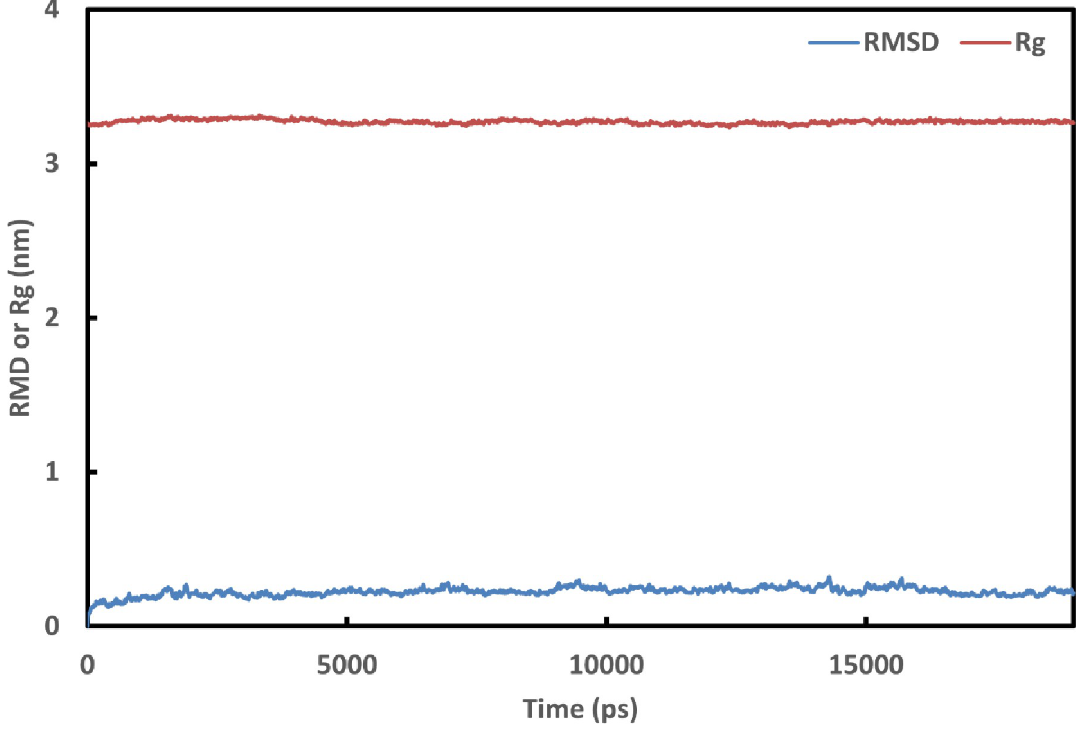
Fig 2. Graphs of RMSD for the backbone atoms and Rg as a function of time are shown over the course of a 19-ns